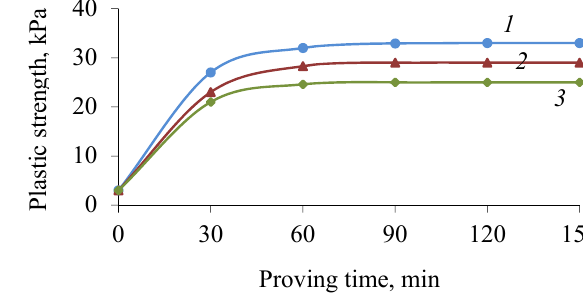
Fig. 3. Change in the proving of the plastic strength of jelly mass of the composition agar and: ( 1 ) molasses + sugar + apple puree (control); ( 2 ) stevioside + apple puree; ( 3 ) stevioside + juice from sea buckthorn berries.